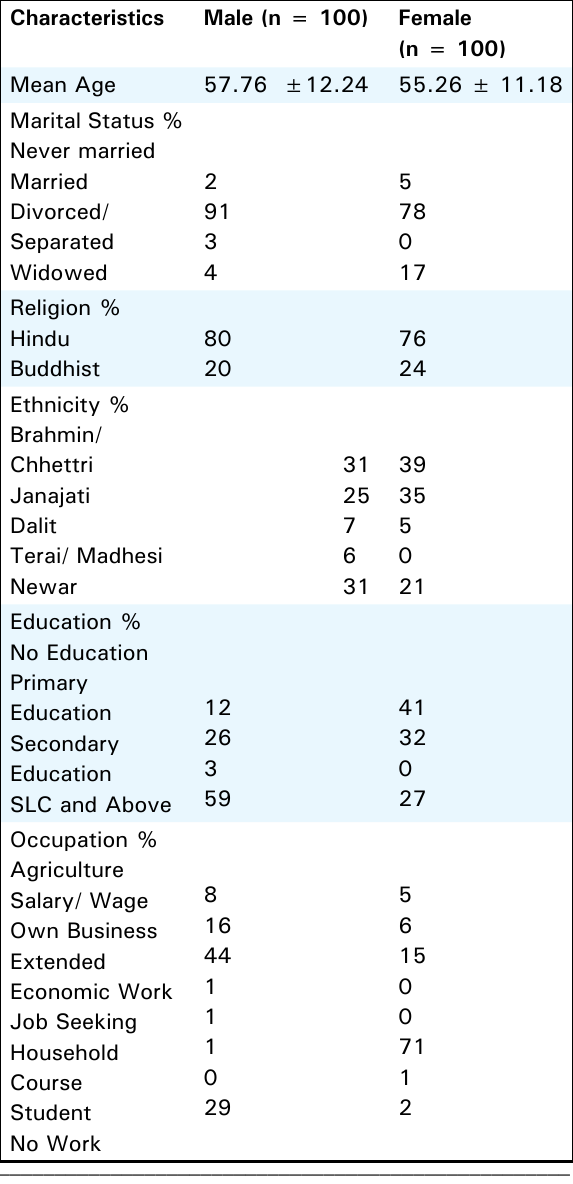
Table 1. Characteristics of the study respondents.